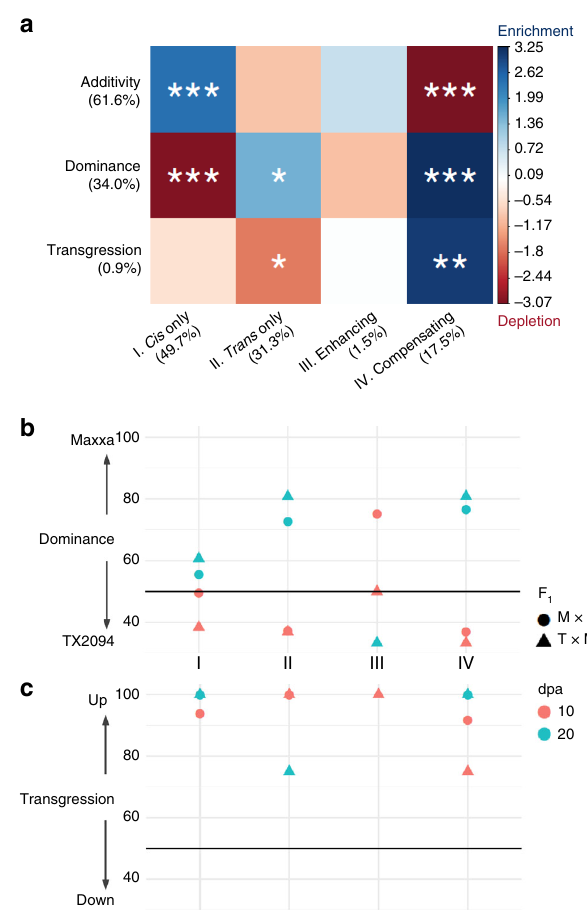
Fig. 3 Relationships between regulatory mechanism and mode of inheritance. a For each combination of inheritance (rows) and cis / trans regulatory (columns) categories, the color shows the magnitude of gene enrichment (blue) and depletion (red) based on residuals of Pearson ’ s Chi- square test of independence. Blue indicates a positive residual when more genes were observed than expected under the null model of independence, and red indicates fewer genes than expected. Statistical signi fi cance was derived from Fisher ’ s exact test, as indicated by * P < 0.05, ** P < 0.01, *** P < 0.001. b Within the category of dominance, percentages of Maxxa- dominant genes are shown for each regulatory category on the x -axis. c Within the category of transgression, the percentage of over-expressed genes are shown for each regulatory category on the x -axis. Source data are provided as a Source Data fi